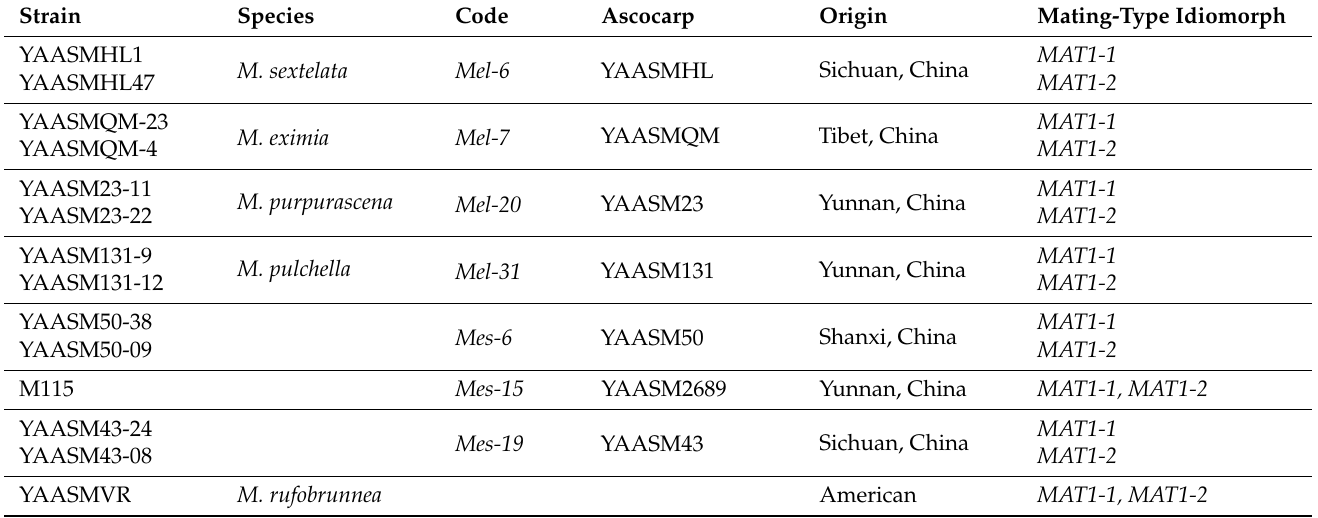
Table 1. The morel strains used in this